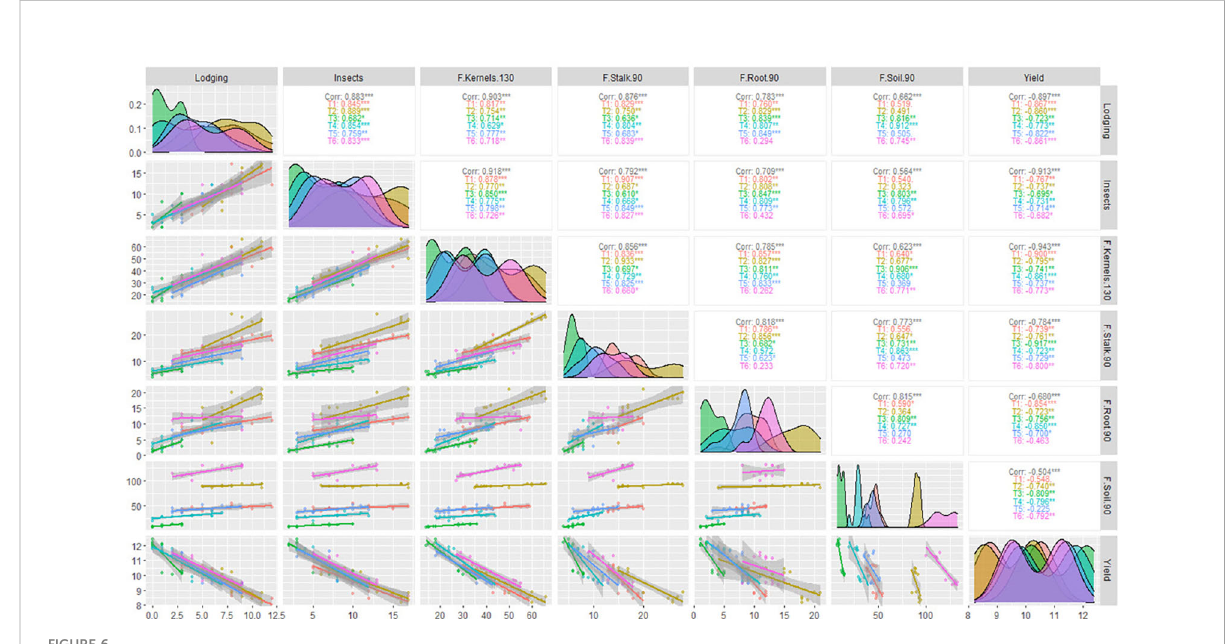
FIGURE 6 Spearman correlation matrix among the studied